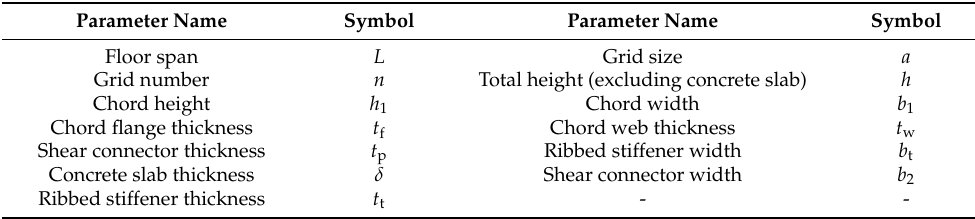
Table 1. Structural size parameter